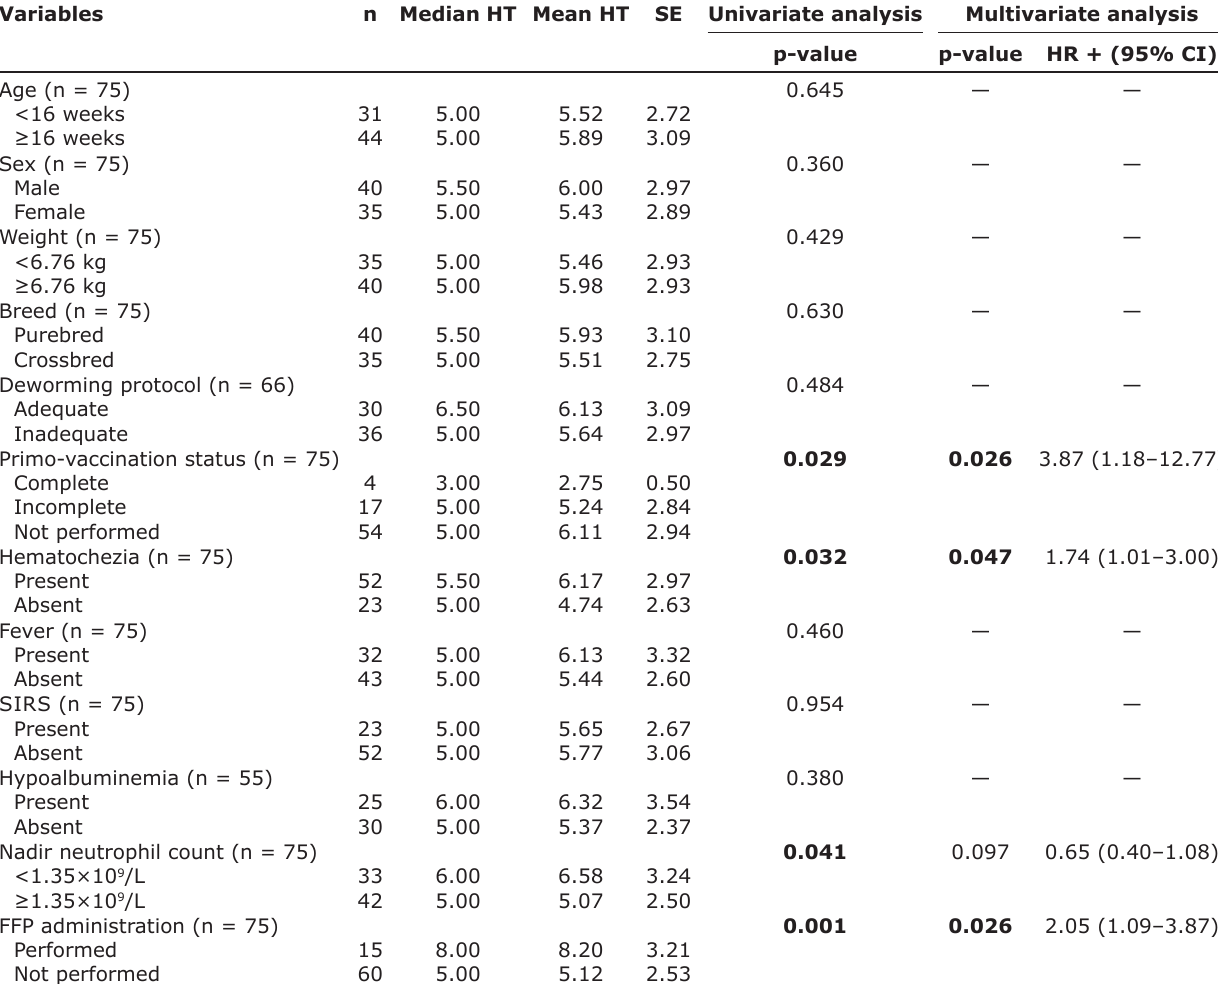
Table-2: Association between patient signalment, clinical presentation, and treatment with HT in the 75 surviving dogs that clinically recovered from presumptive acute viral gastroenteritis. Variables